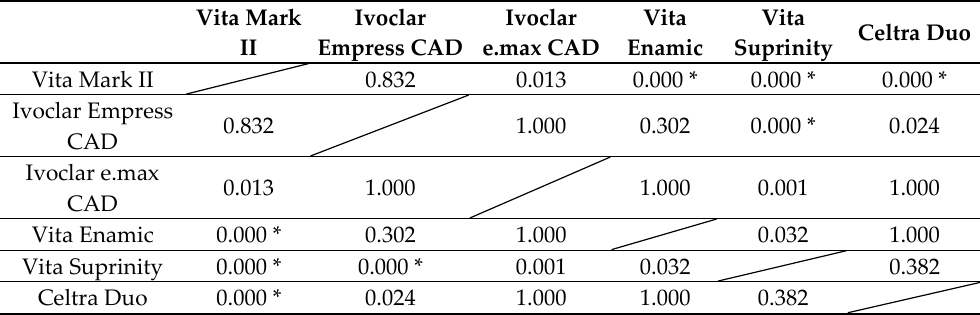
Table A8. Comparison of the different ceramics during the pull-off test: Variolink II.